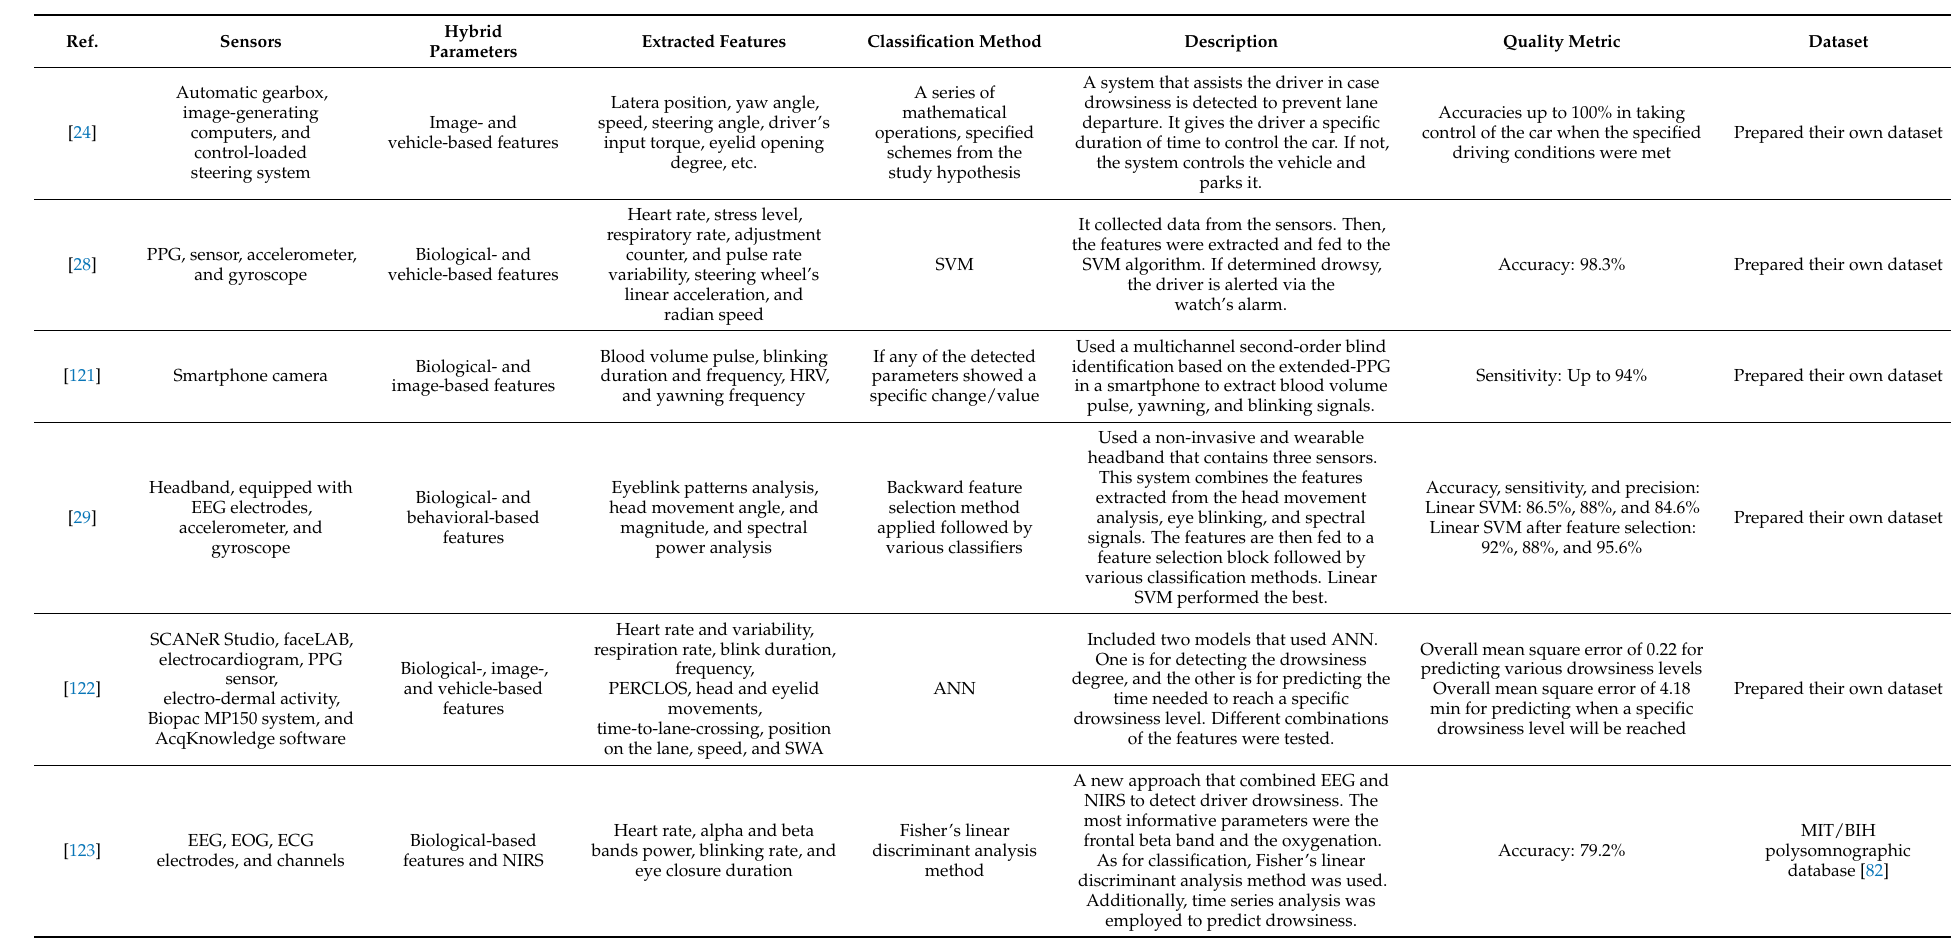
Table 8. Hybrid-based drowsiness detection